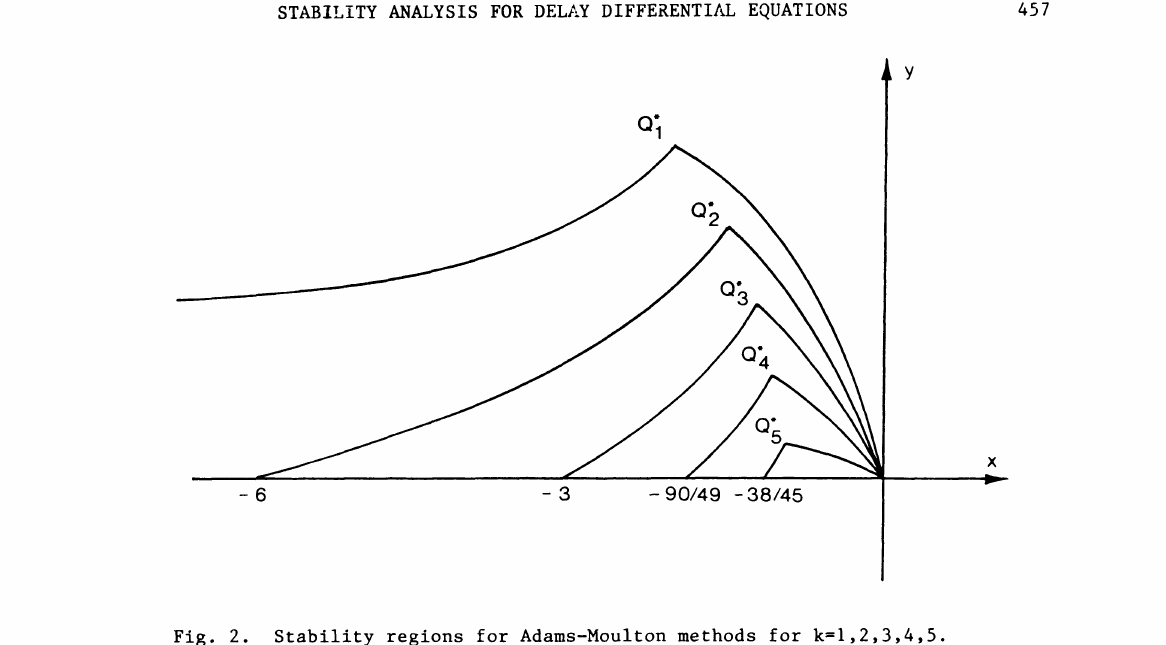
Fig. 2. Stability regions for Adams-Moulton methods for